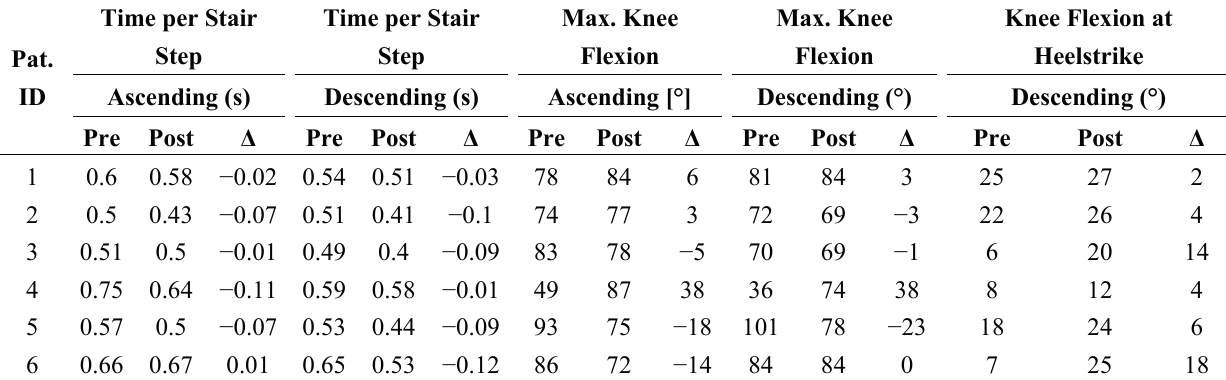
Table 3. Mean values of the evaluated gait parameters during stair climbing before (Pre) and after (Post)